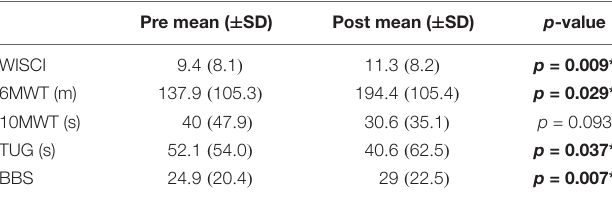
TABLE 1 | Improvement in functional outcomes.